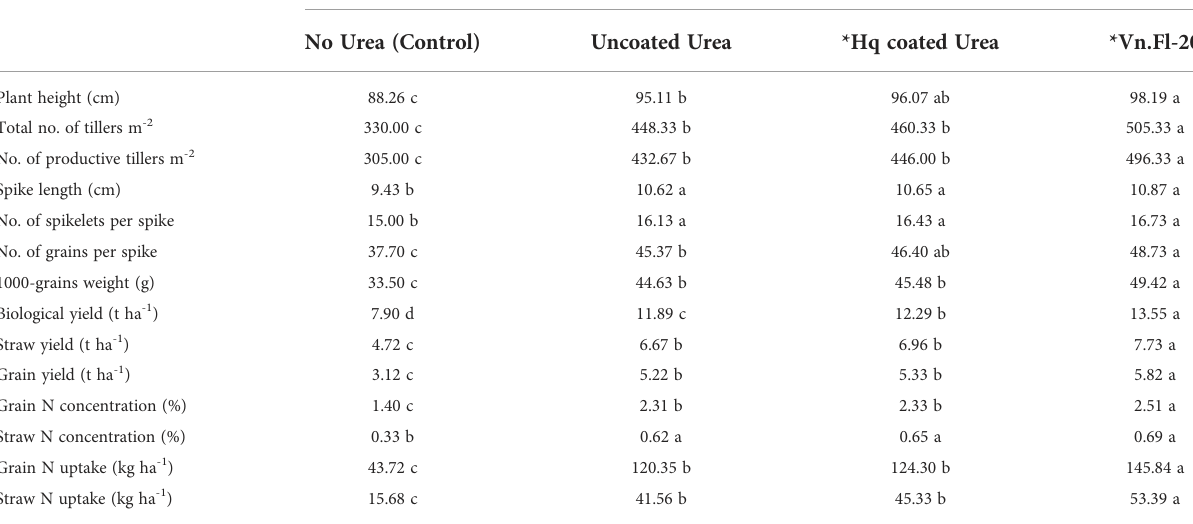
TABLE 5 Comparative effect of Vachellia nilotica extract and hydroquinone (Hq) coated urea on the growth, yield, and N status of wheat under fi eld conditions (2020-21).